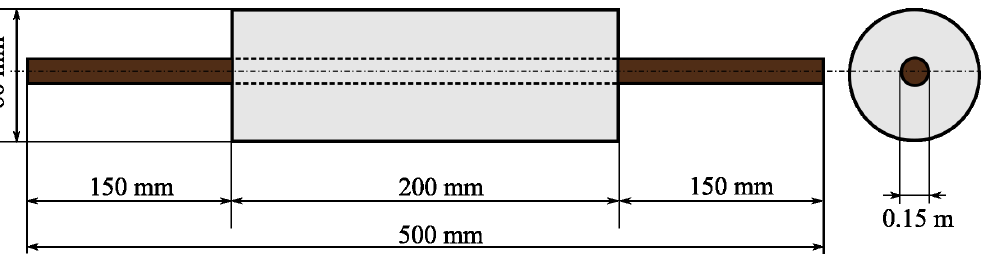
Figure 4. Schematics and actual photos of the specimens used for the experiment.